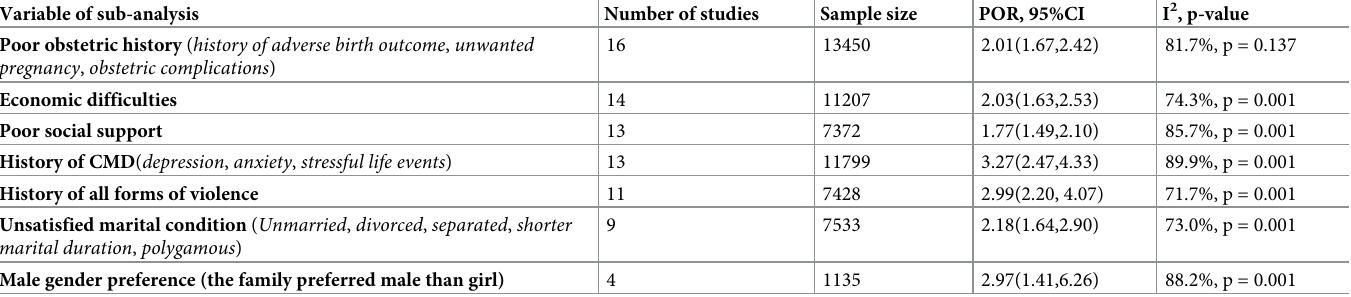
Table 3. Risk factors associated with antenatal depression, a meta-analysis of studies in the low- and middle-income countries (N = 64, 2007–2017), (estimate from random effect model after trim and fill analysis). Variable of sub-analysis